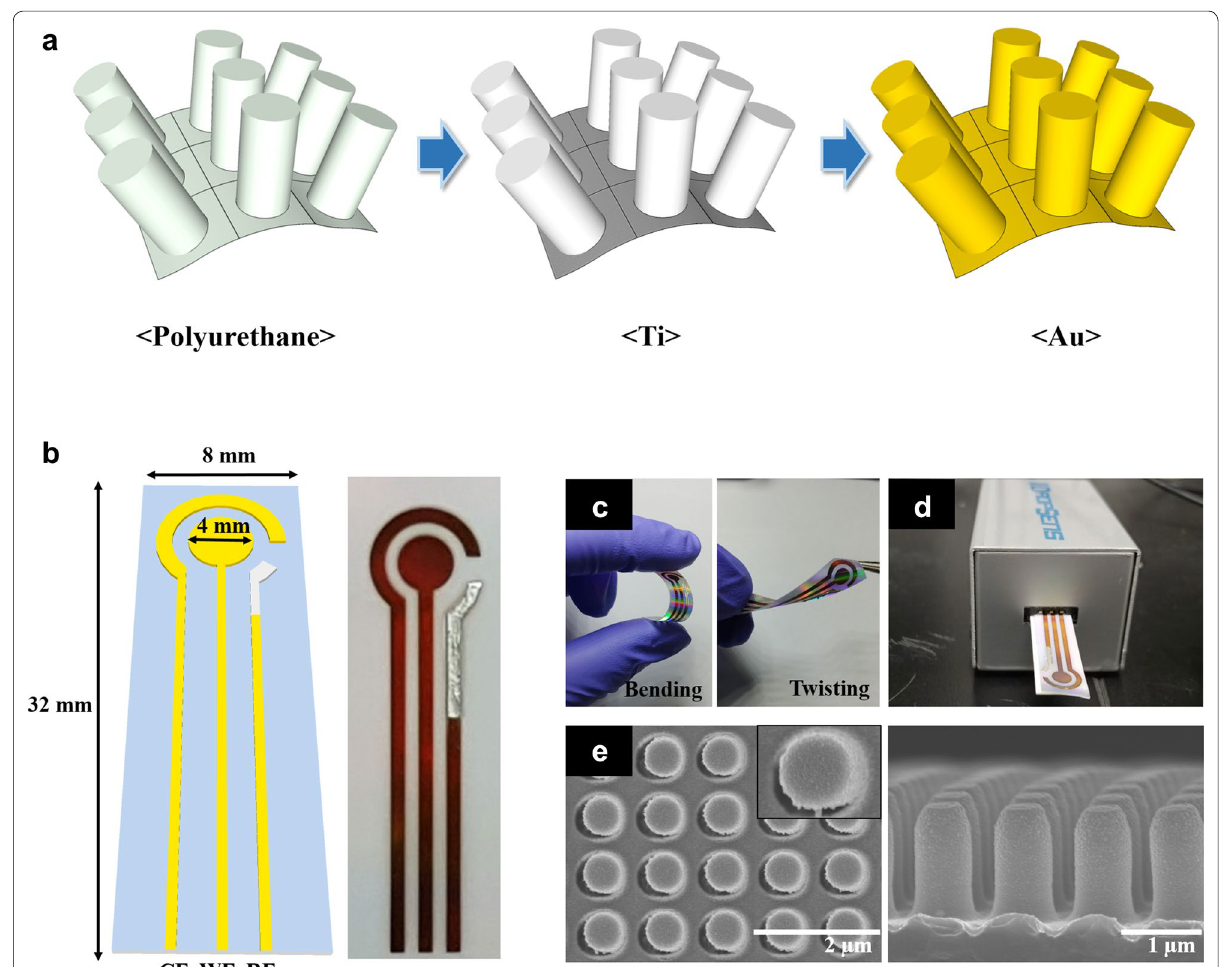
Fig. 1 a Schematic illustration of NPE fabrication processes. b Scheme and photographic image of NPE. Photographic images of c bending and twisting status of NPE and d confirmation of USB connection. e SEM images of top and side view of